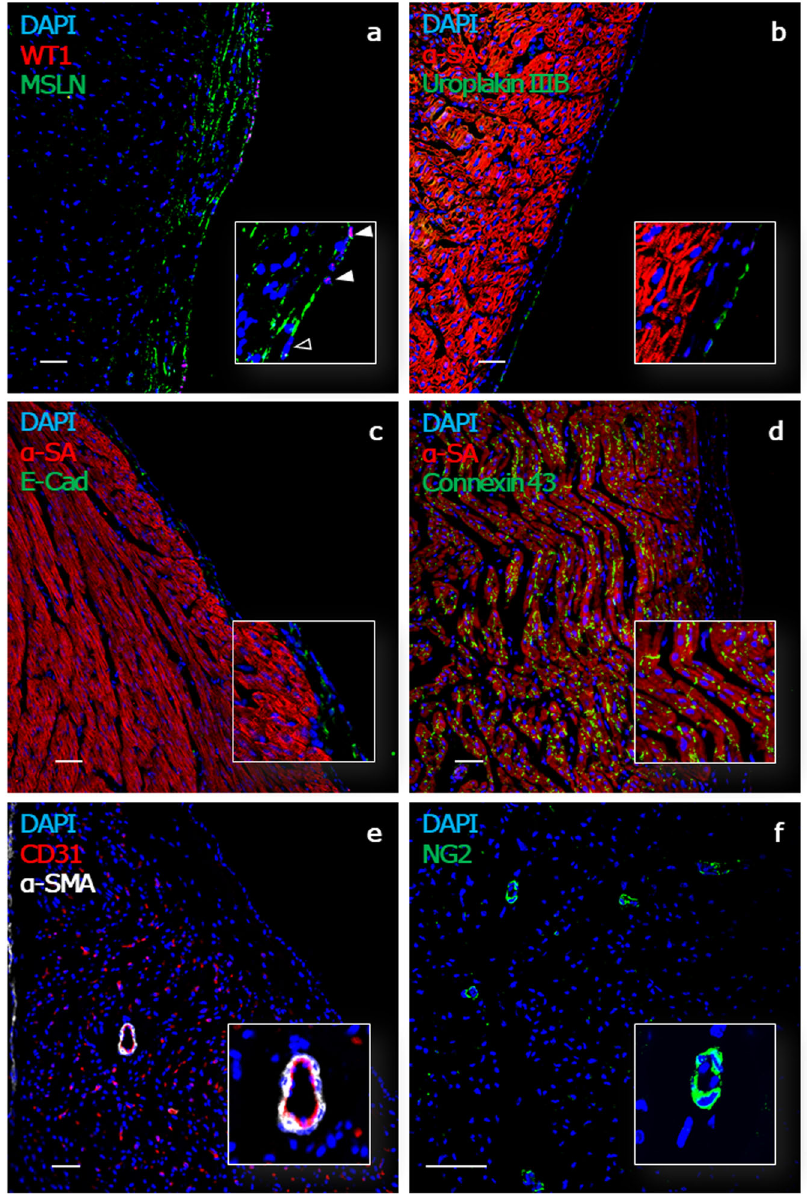
Fig. 2 Epicardial slices characterization. Confocal microscopy analysis of formaldehyde- fi xed OCT-embedded porcine epicardial slices con fi rms the presence of an intact epicardial layer identi fi ed by their localization and fl at morphology and expressing WT1 and MSLN (WT1 + epicardial cell indicated with full arrowhead, WT1 − epicardial cell indicated with empty arrowhead) ( a ), the Uroplakin IIIB ( b ), and E-cadherin ( c ). The cardiomyocytes within the slice display α -sarcomeric actin structures and the expression of connexin 43 within the gap junctions ( d ), indicative of the preserved myocardial architecture. CD31 identi fi es vascular structures, including arterioles surrounded by smooth muscle cells expressing α -SMA ( e ). CD31 + capillaries, associated with NG2 + pericytes, are visualized in higher magni fi cation images ( f ). Nuclei are labeled with DAPI. Scale bar, 50